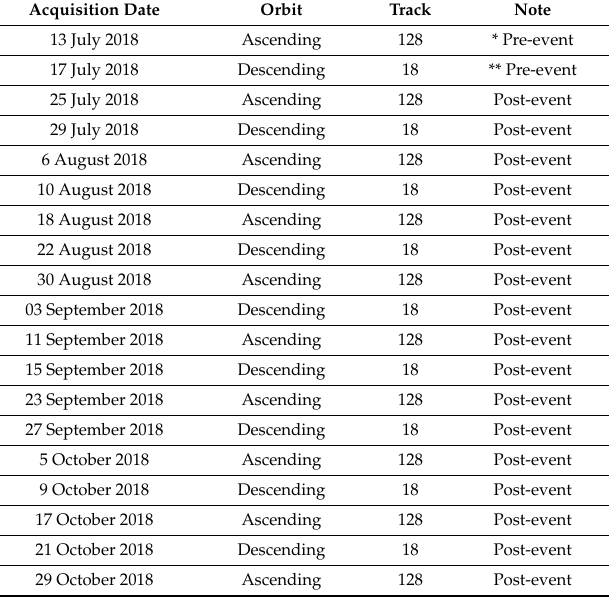
Table 1. Sentinel-1 SAR images used for water outflow